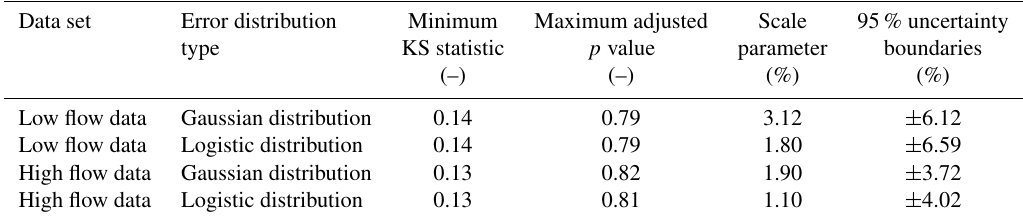
Table 3. Kolmogorov–Smirnov test results (simultaneous discharge measurements).